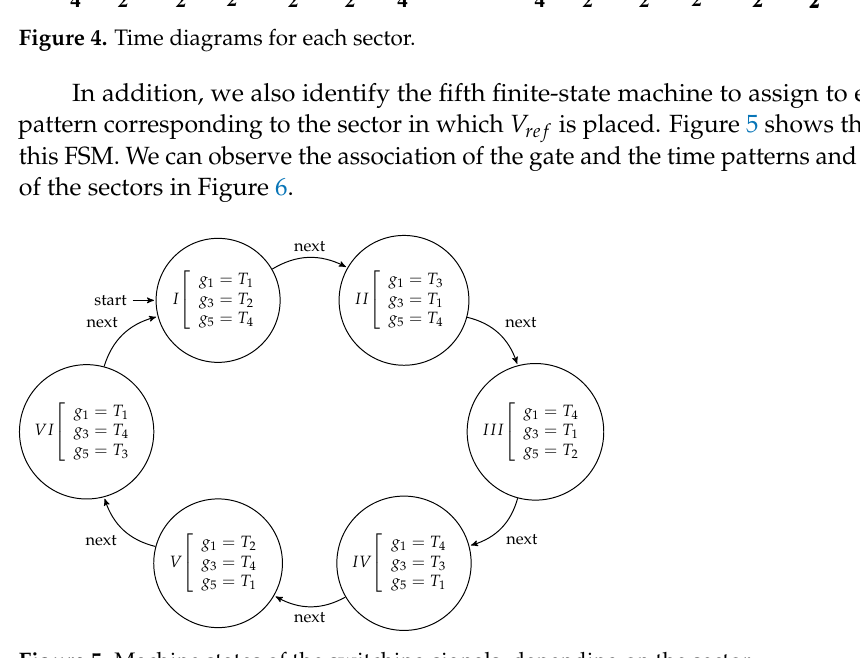
Figure 5. Machine states of the switching signals, depending on the